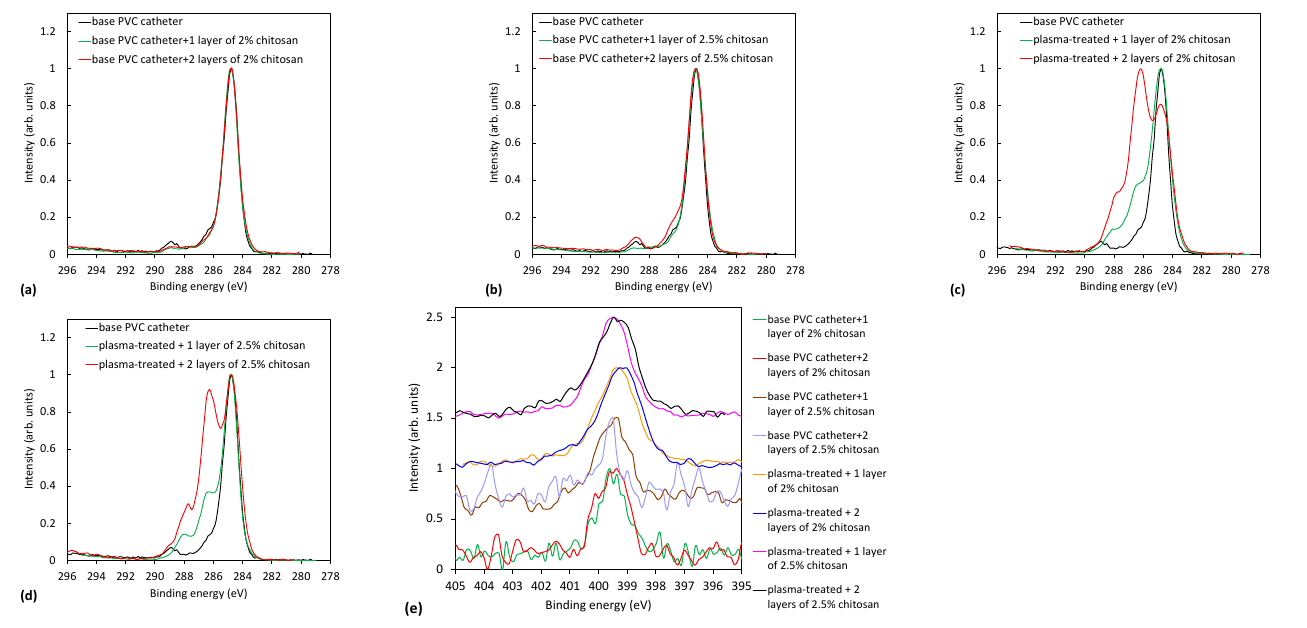
Figure 8. Comparison of XPS spectra of untreated and uncoated PVC catheters with coated catheters: ( a ) soaking in 2% chitosan solution without plasma treatment; ( b ) soaking in 2.5% wt. macromolecular chitosan solution without plasma treatment; ( c ) 2% chitosan coating with two-step plasma treatment; ( d ) 2.5% wt. chitosan coating with two-step plasma treatment; and ( e ) comparison of nitrogen spectra for all coated PVC catheters.